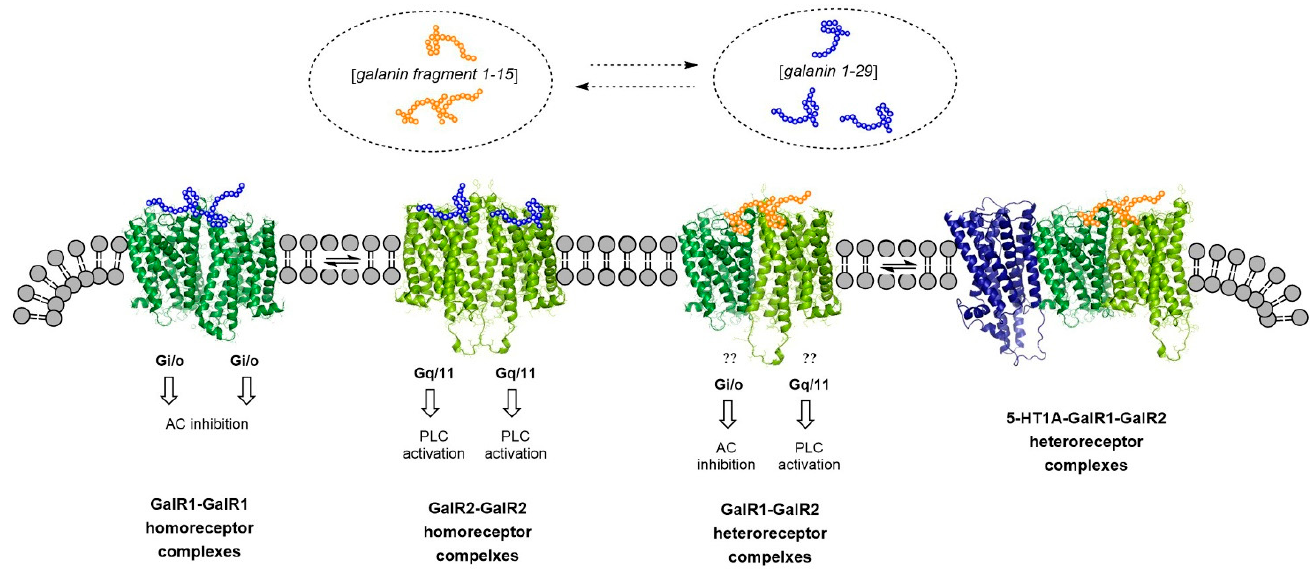
Figure 1. To the left it is shown the location of GalR1 homodimer and the GalR2 homodimer. They are located in the plasma membrane with high affinity mainly for galanin 1–29 (blue circles). GalR1 signals via inhibition of adenylyl cyclase (AC) mediated through Gi/o while GalR2 mainly signals via phospholipase C (PLC) activation mediated through Gq/11. The GalR1-GalR2 heterodimer has instead a high affinity for galanin fragment 1–15 (yellow circles) (to the right). This heterodimer is in equilibrium with the 5-HT1AR-GalR1-GalR2 in the plasma membrane. In this heterotrimeric complex the Gal 1–15 fragment enhances through allosteric mechanisms the 5-HT1AR signaling mainly through activation of GalR2. As a result, antidepressant-like effects were observed upon cotreatment with 5-HT1AR agonist and the galanin fragment given i.c.v. Moreover, an increased expression of the 5-HT1AR protomer was observed.